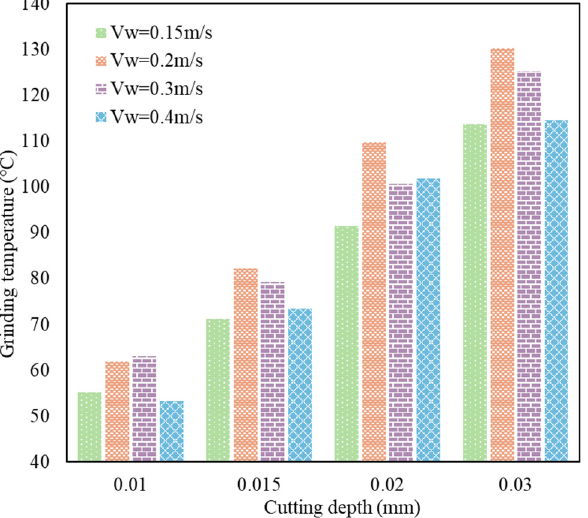
Figure 14. The influence of process parameters on grinding temperature.